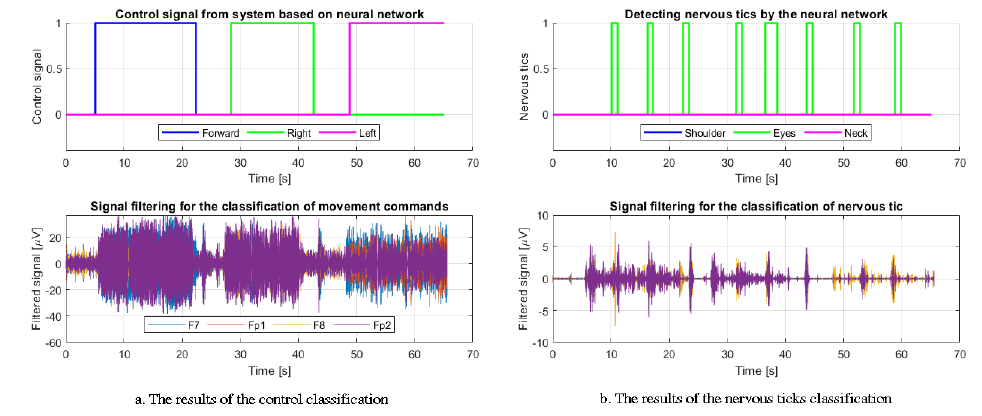
Figure 19. An example of the classification of movement commands and nervous tics—eye blinking.